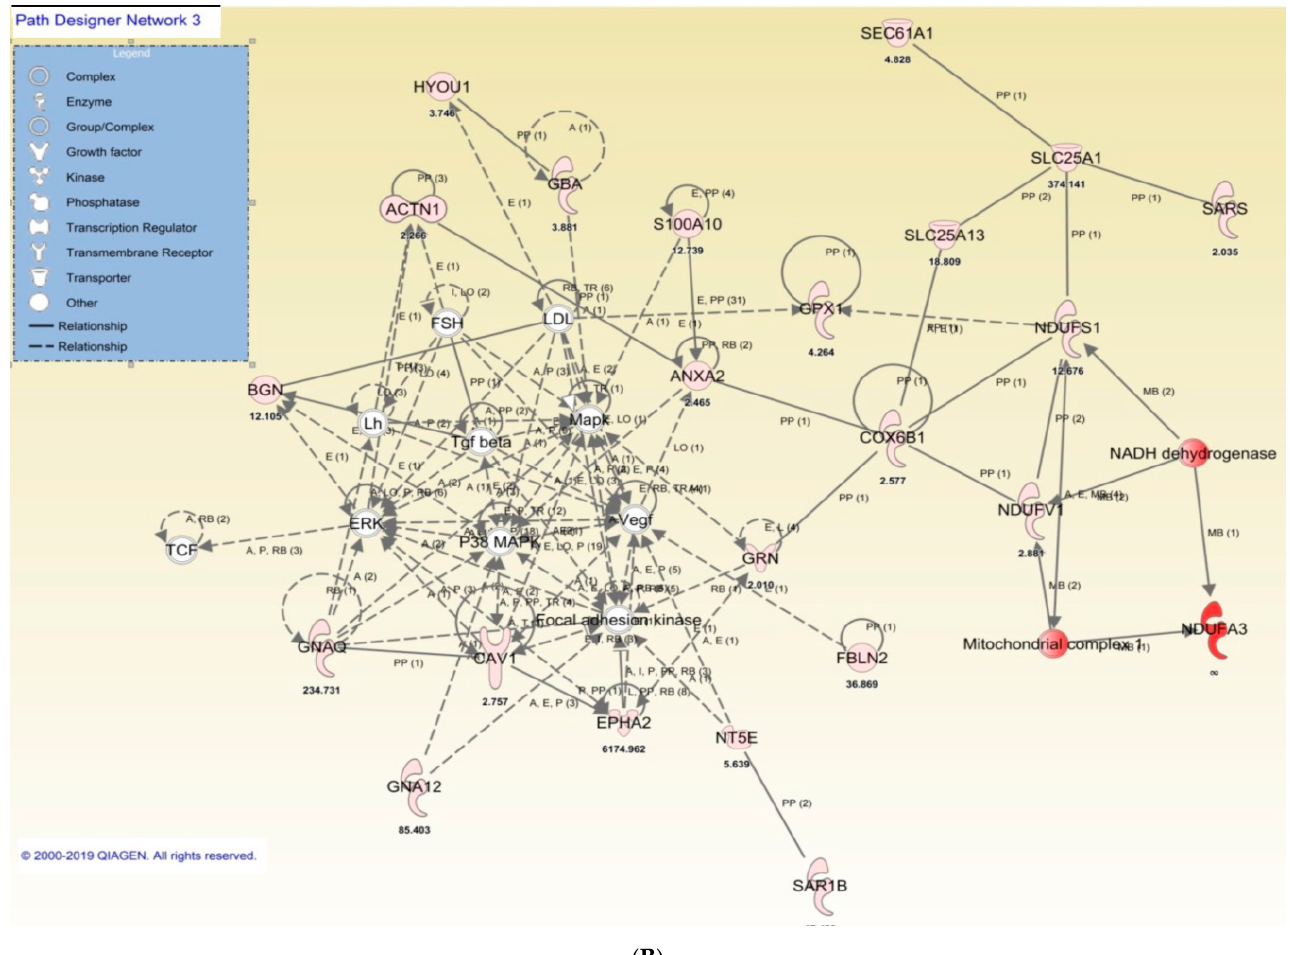
Figure 6. ( A ) Ingenuity Pathway Analysis (IPA) of the 86 proteins in the dataset that were found to be significantly differentially expressed between the bulk/undifferentiated HC and OP samples. Some of the identified proteins (highlighted in pink) were shown to have cellular involvements in signaling network pathway interactions. In the core of the network (in red), interactions of MAPK, ERK 1/2, PI3K, and integrin connected to osteopathogenesis were identified. Proteins in grey and white colors represent molecules from the IPA database that make up the network. ( B ) Ingenuity Pathway Analysis (IPA) of 196 proteins with marked expression changes between undifferentiated, osteogenic, and chondrogenic differentiated MSSCs in both OP and HC cells. Some of these proteins (highlighted in pink, as described above) were implicated in different signaling networks involving bone and connective tissue disorders. The network analysis was generated through the use of IPA (QIAGEN Inc., https://www.qiagenbioinformatics.com